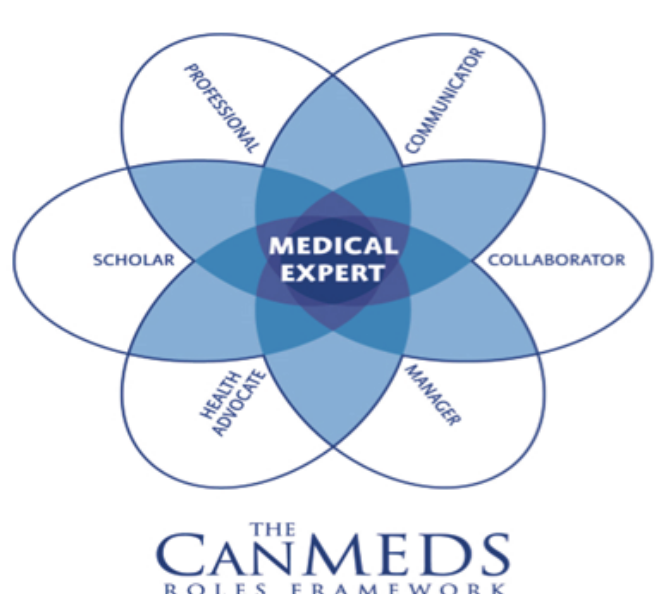
Figure 2: Example of National Competency Framework in Canada (CanMEDs)